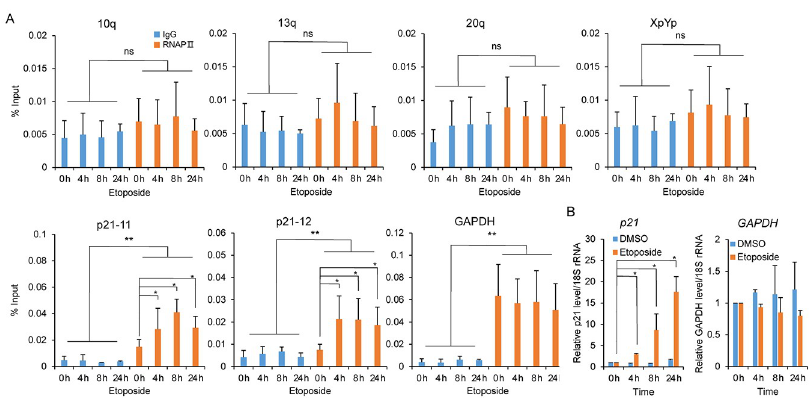
Fig 4. ChIP–qPCR to assay RNAPII binding at subtelomeres after exposure to etoposide. HeLa cells incubated with etoposide at 100 μ M for the indicated times were subjected to ChIP assays using an anti-phosphorylated RNAPII antibody (pS2) and IgG as a control. Associated DNA fragments were PCR-amplified for p21, GAPDH, and subtelomeres as indicated; p21-11 and p21-12 indicate the p21 gene at 0.2 and 2.1 kb from the transcription start site, respectively. Results are presented as percentages of input DNA. Bars represent the SDs of at least three replicates. Student’s t -test was used to compare DNA levels between RNAPII-ChIP and IgG-ChIP; �� P < 0.05 and ns indicates P � 0.05. Mann-Whitney U -test was used to compare DNA levels between each h and 0 h; � P < 0.05. B. RT–qPCR for p21 and GAPDH in HeLa cells treated with DMSO (vehicle alone) or etoposide at 100 μ M for the indicated times. p21 and GAPDH levels were normalized to 18S rRNA and expressed as fold changes relative to 0 h. Mann-Whitney U -test was used to compare DNA levels between each h and 0 h; � P <